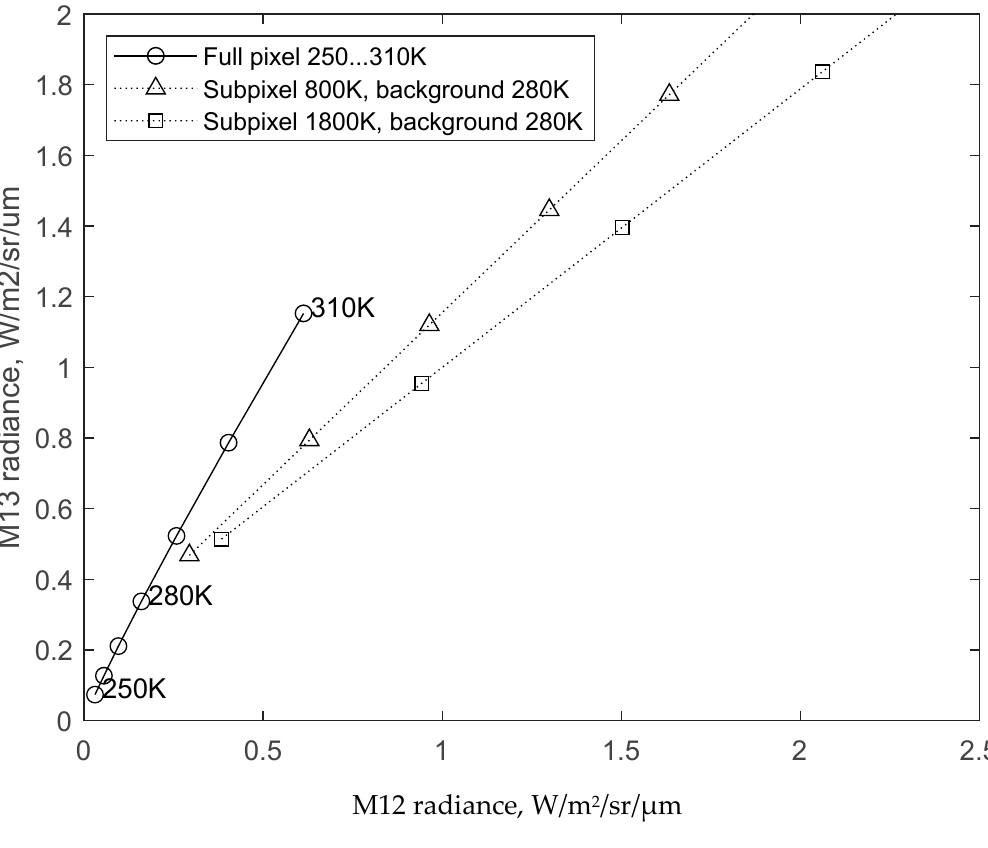
Figure 5. Modeled sum of radiances in VIIRS bands M12 and M13 for different background temperatures (250…310 K) and different subpixel heat source temperatures (800 K or 1800 K) and sizes.